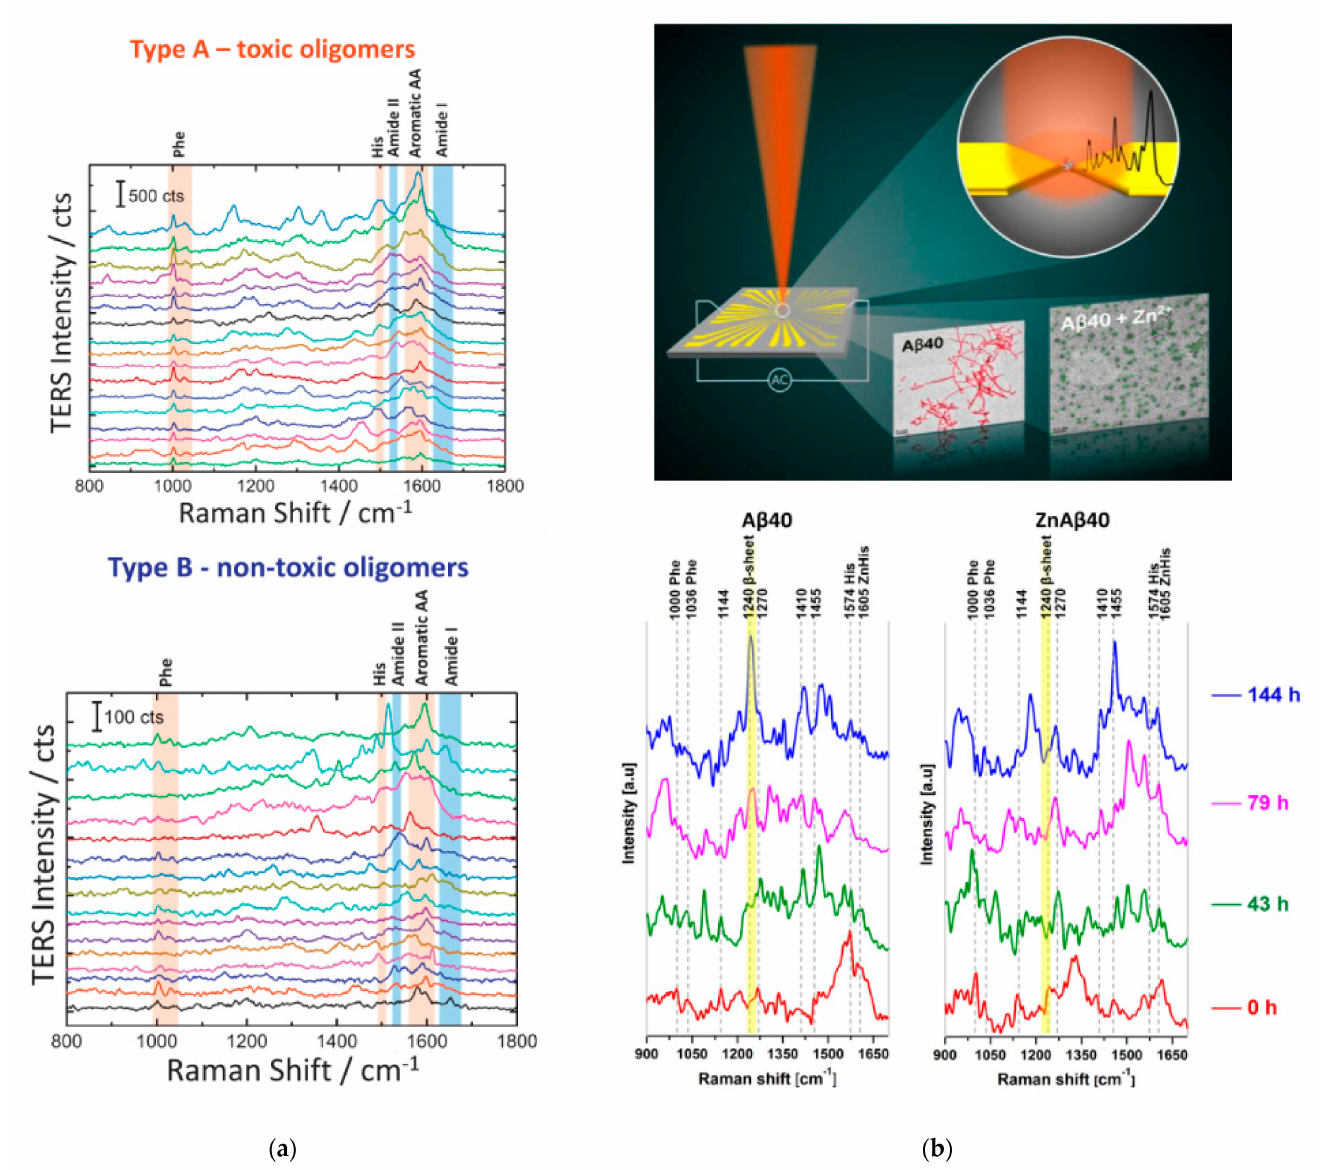
Figure 5. ( a ) TERS spectra of toxic and non-toxic oligomer samples. Part of figure reproduced from Ref. [111] with permission. Copyright 2018 WILEY-VCH Verlag GmbH & Co. KGaA, Weinheim. DEP inside the gap between a pair of electrodes and the SERS signal is simultaneously measured (upper inset); TEM images of A β 40 aggregates with and without the presence of Zn 2+ (lower insets); below: SERS spectra of A β 40 in solution trapped with the nanogap device with and without Zn 2+ after different incubation times. Figure adapted with permission from Ref. [112]. Copyright